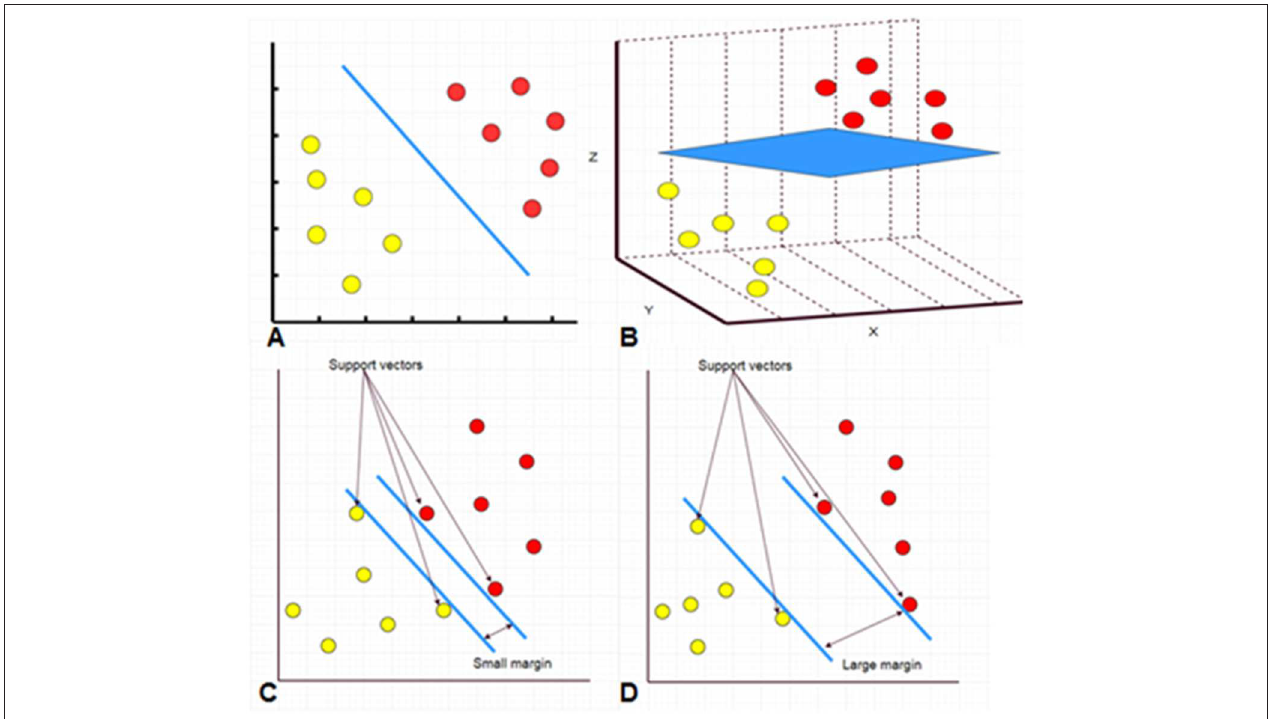
FIGURE 2 | A hyperplane separating two classes of data points in 2D space ( A , blue line). A hyperplane separating two classes of data points in 3D space ( B , blue sheet). Separation in more dimensions is also performed but it is difficult to be presented on a 2D manuscript. The support vectors are data that are closer to the hyperplane. The larger the margin between the hyperplanes, the better the classification (C,D) .